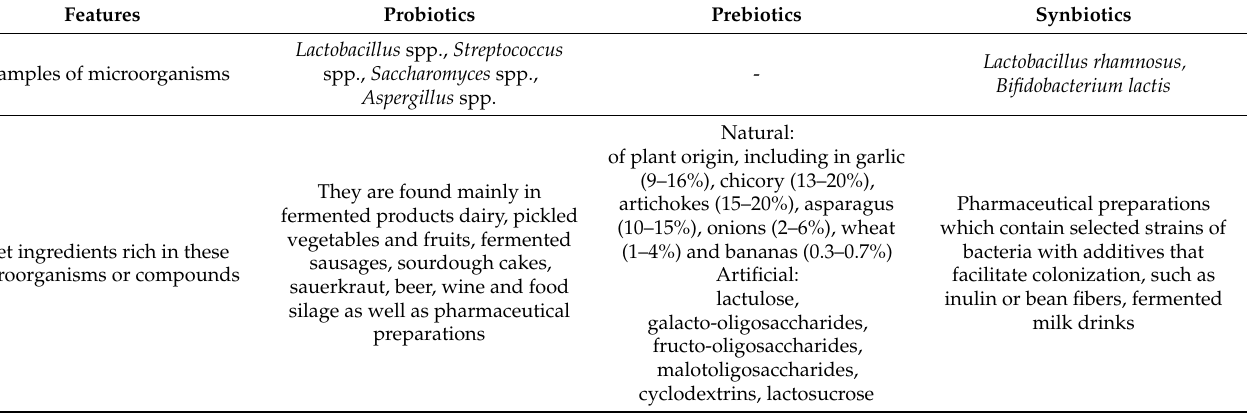
Table 3. Comparison of probiotics, prebiotics and symbiotics (based on [121–123].